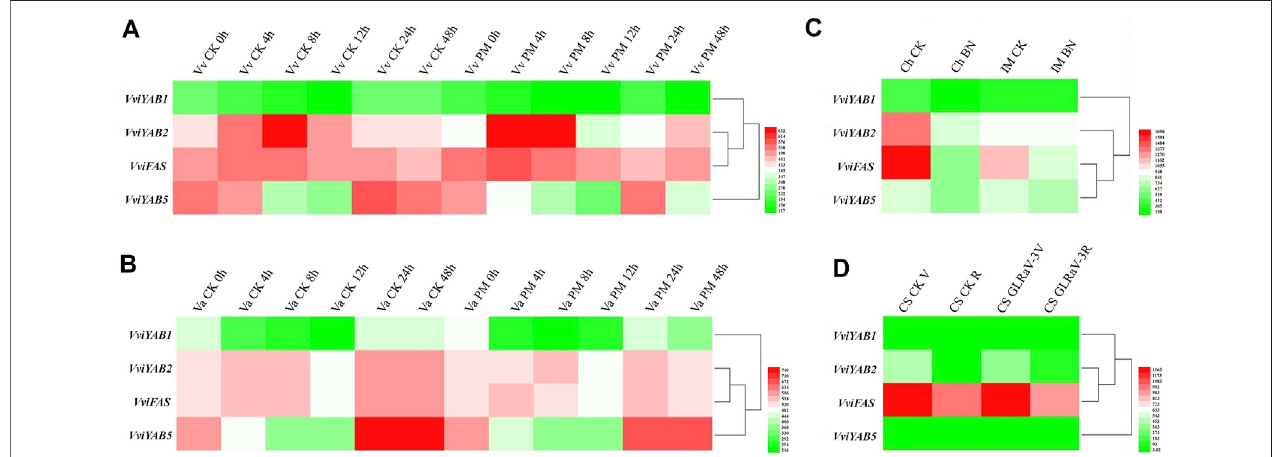
FIGURE8| Expressionpatternsof VviYAB genesinresponsetobioticstresses. (A,B) Thesusceptiblevariety V.vinifera cv.CabernetSauvignon ” andtheresistant variety V. aestivalis cv “ Norton ” plants were grown in an environmental chamber and inoculated with Erysiphe necator conidiospores (PM). Inoculated leaves were harvested at 0, 4, 8, 12, 24, and 48 h after inoculation (GSE6404). (C) Field-grown plants of V. vinifera cv. Chardonnay (Ch) and Incrocio Manzoni (IM) naturally infected with Bois Noir phytoplasma (BN), compared to healthy samples (GSE12842). (D) V. vinifera cv. Cabernet Sauvignon (CS) ” was infected with GLRaV-3 during veraison (CS GLRaV-3V) and ripening (CS GLRaV-3R) stages of berry development